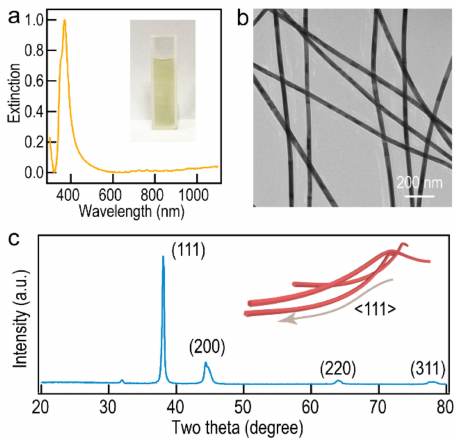
Figure 1. ( a ) Extinction spectrum of the purified Ag NWs. The inset is the photograph of the purified Ag NWs. ( b ) TEM image of the purified Ag NWs. ( c ) XRD pattern of purified Ag NWs. The inset is the model of Ag NWs.